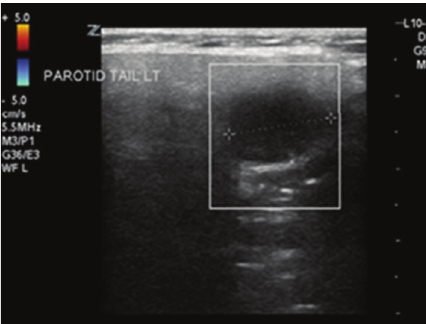
Figure 1: Ultrasound of parotid/neck region. Within the right parotid a 15mm hypoechoic lesion was seen. Initial differentials: salivary gland tumour and abnormal possibly necrotic intraparotid node.